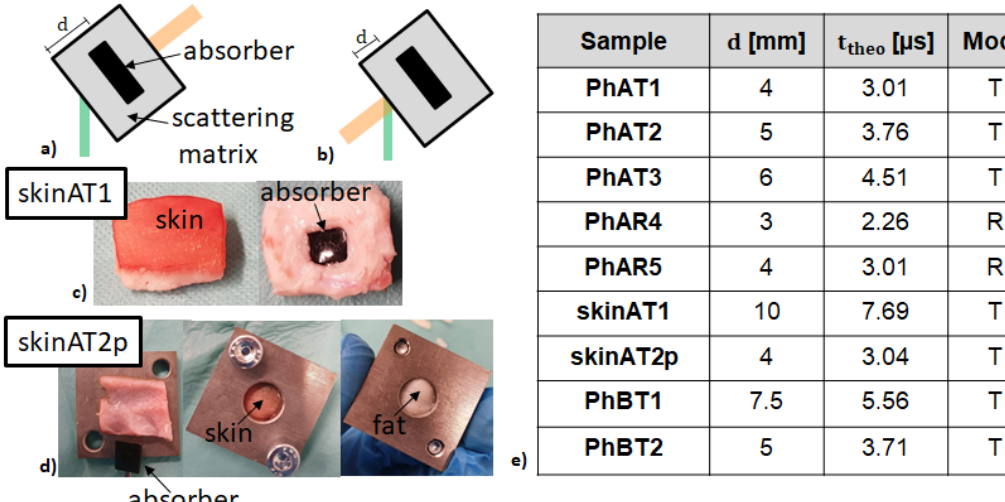
Figure 5. The transmission setup (T) is sketched, and the phantom parts are marked ( a ). The reflection setup (R) is illustrated ( b ). Pictures of the two skin tissue samples are shown: skinAT1 with an absorber at the bottom ( c ) and skinAT2p with an absorber between skin and fat ( d ). The corresponding detection distances, theoretical detection times, and measurement modes are summarized in the table ( e